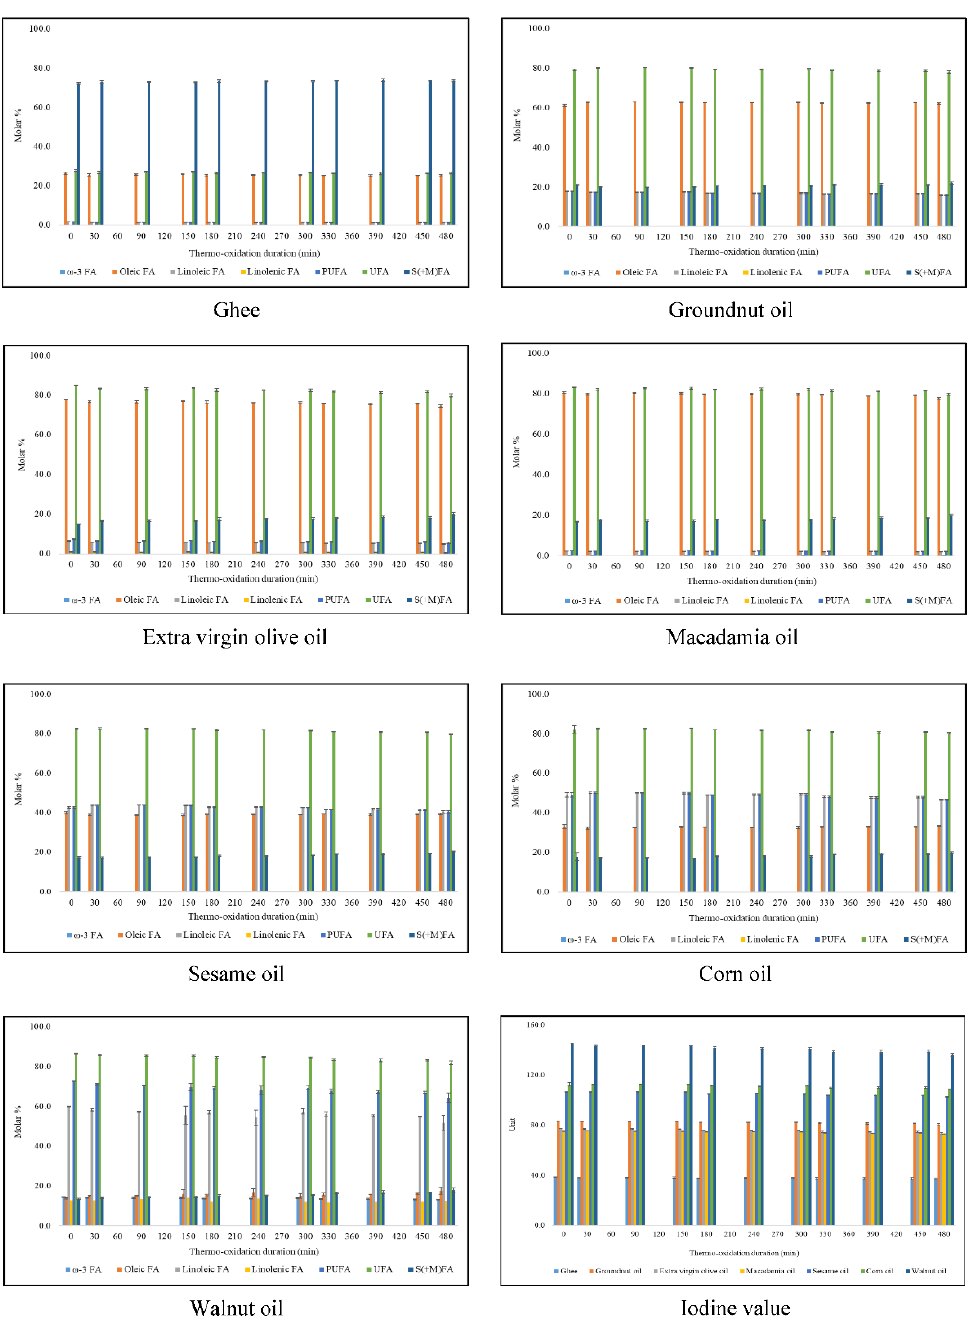
Figure 6. Changes in acyl groups and iodine values of thermally stressed culinary oils subjected to a discontinuous thermo-oxidation at 180 °C for 480 min. The values are presented as mean ± SD discontinuous thermo-oxidation at 180 ◦ C for 480 min. The values are presented as mean ± SD molar molar % (FA) and mean ± SD unit (IV) of oil. % (FA) and mean ± SD unit (IV) of